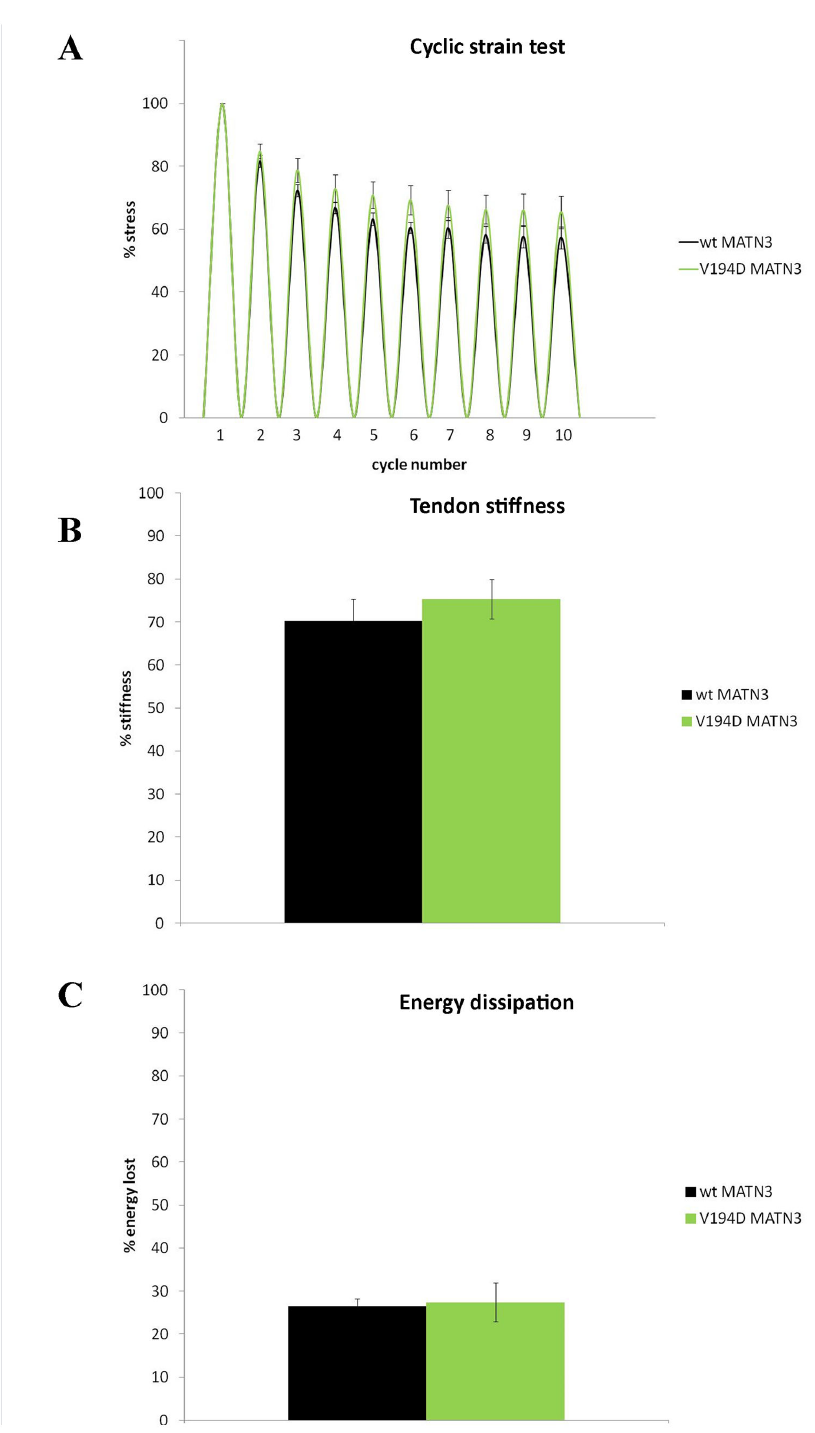
Figure 7. Results of the cyclic test experiment on matrilin 3 mutant tendons. A ) Stress per cycle plot showing a decrease in force needed to extend mutant tendons to the same strain as the wild type controls. We found no difference between the wild type and mutant tendons at 3 weeks. B ) Calculation of the proportion of energy dissipated by the Achilles tendons in 10th cycle, showing no difference between the wild type and mutant matrilin 3 tissue at 3 weeks. C ) Tendon stiffness at 10 th cycle calculated in relation to stiffness at cycle 1 (100%) showing mutant matrilin 3 tendons did not become more lax than the wild type controls in the cyclic testing experiment (n≥3). doi: 10.1371/journal.pone.0082412.g007 PLOS ONE |